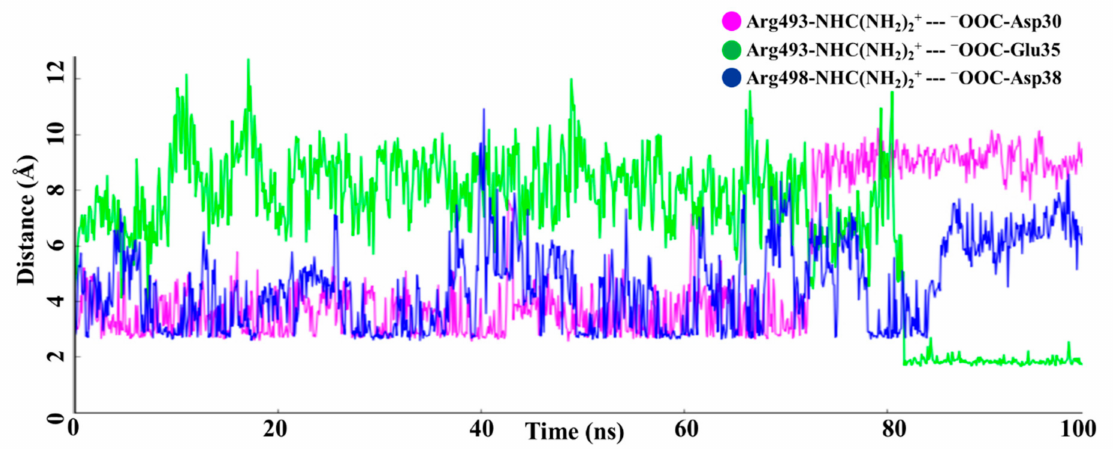
Figure 6. The distance between residues participating in the salt bridge (electrostatic interaction) during the entire MD